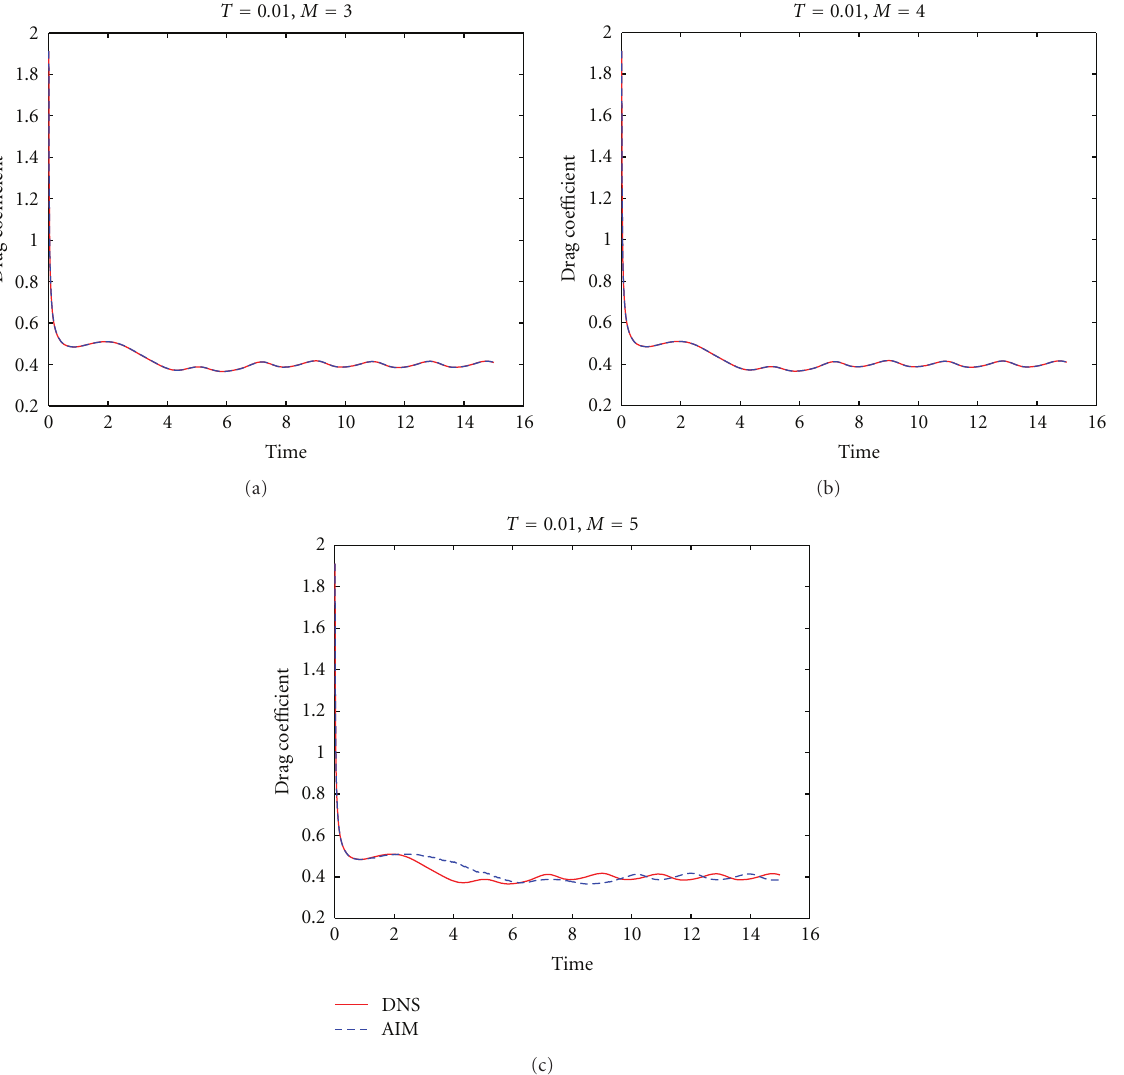
Figure 4: Transient dynamics: Re = 400, drag coe ffi cient for T = 0 . 01 with various number of M . From top to bottom: M = 3,4, and 5.